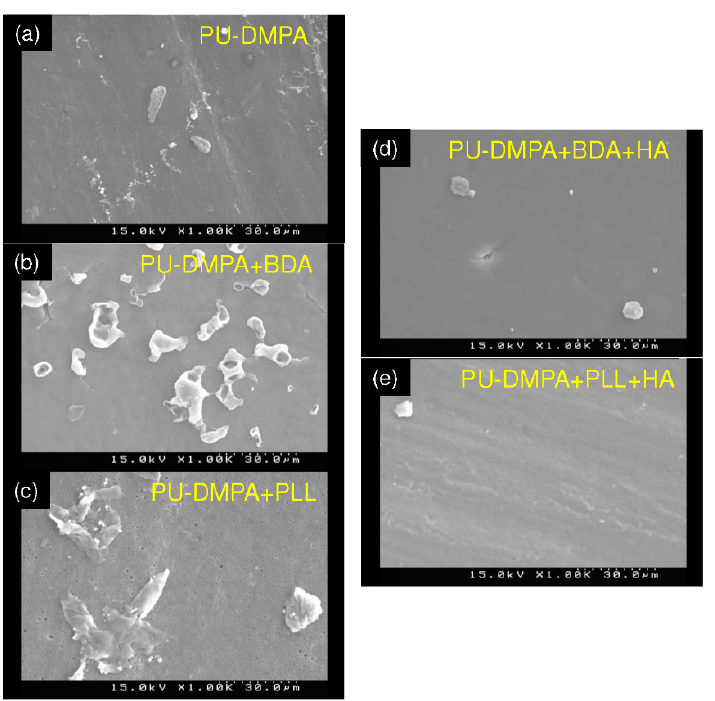
Figure 10. SEM images of platelets adhered onto the surface of the PU-DMPA ( a ), the BDA-modified PU-DMPA ( b ), the PLL-modified PU-DMPA ( c ), the HA-modified PU-DMPA-BDA ( d ), and the HA-modified PU-DMPA-PLL ( e ).